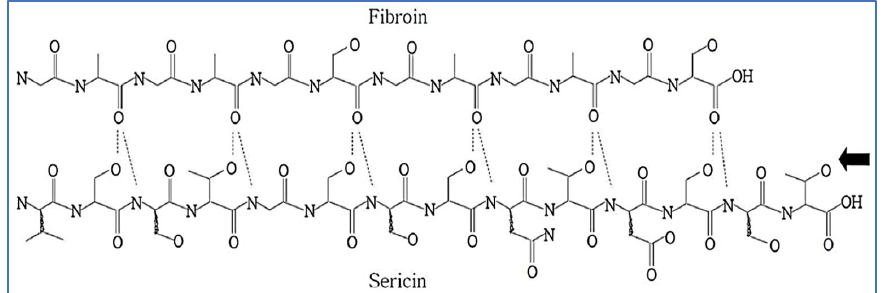
Figure 1. Structure of silk showing the intermolecular hydrogen bonds between the fibroin and sericin. Reproduced with permission from Lee et al. [11], 2004, John Wiley and Sons (originally Scheme 1).